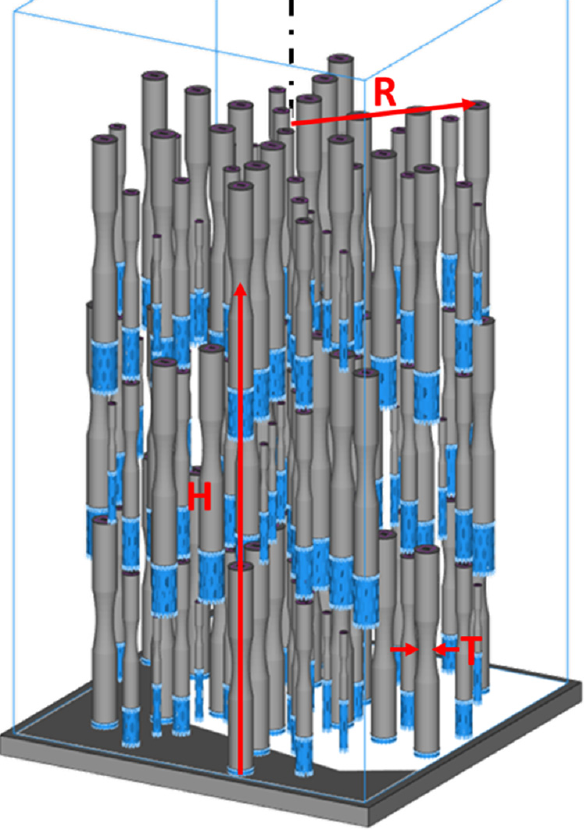
Figure 2. Oblique view of the build for fatigue specimens of the full factorial DOE. Illustrated with the red arrows are the three design parameters—Height (H): distance from the base plate to centroid of a part; Radial distance (R): distance from the middle of the build plane (central axis represented by dashed black line) to centroid of a part; and Thickness (T): diameter of the thinnest portion of the gauge section of a part.